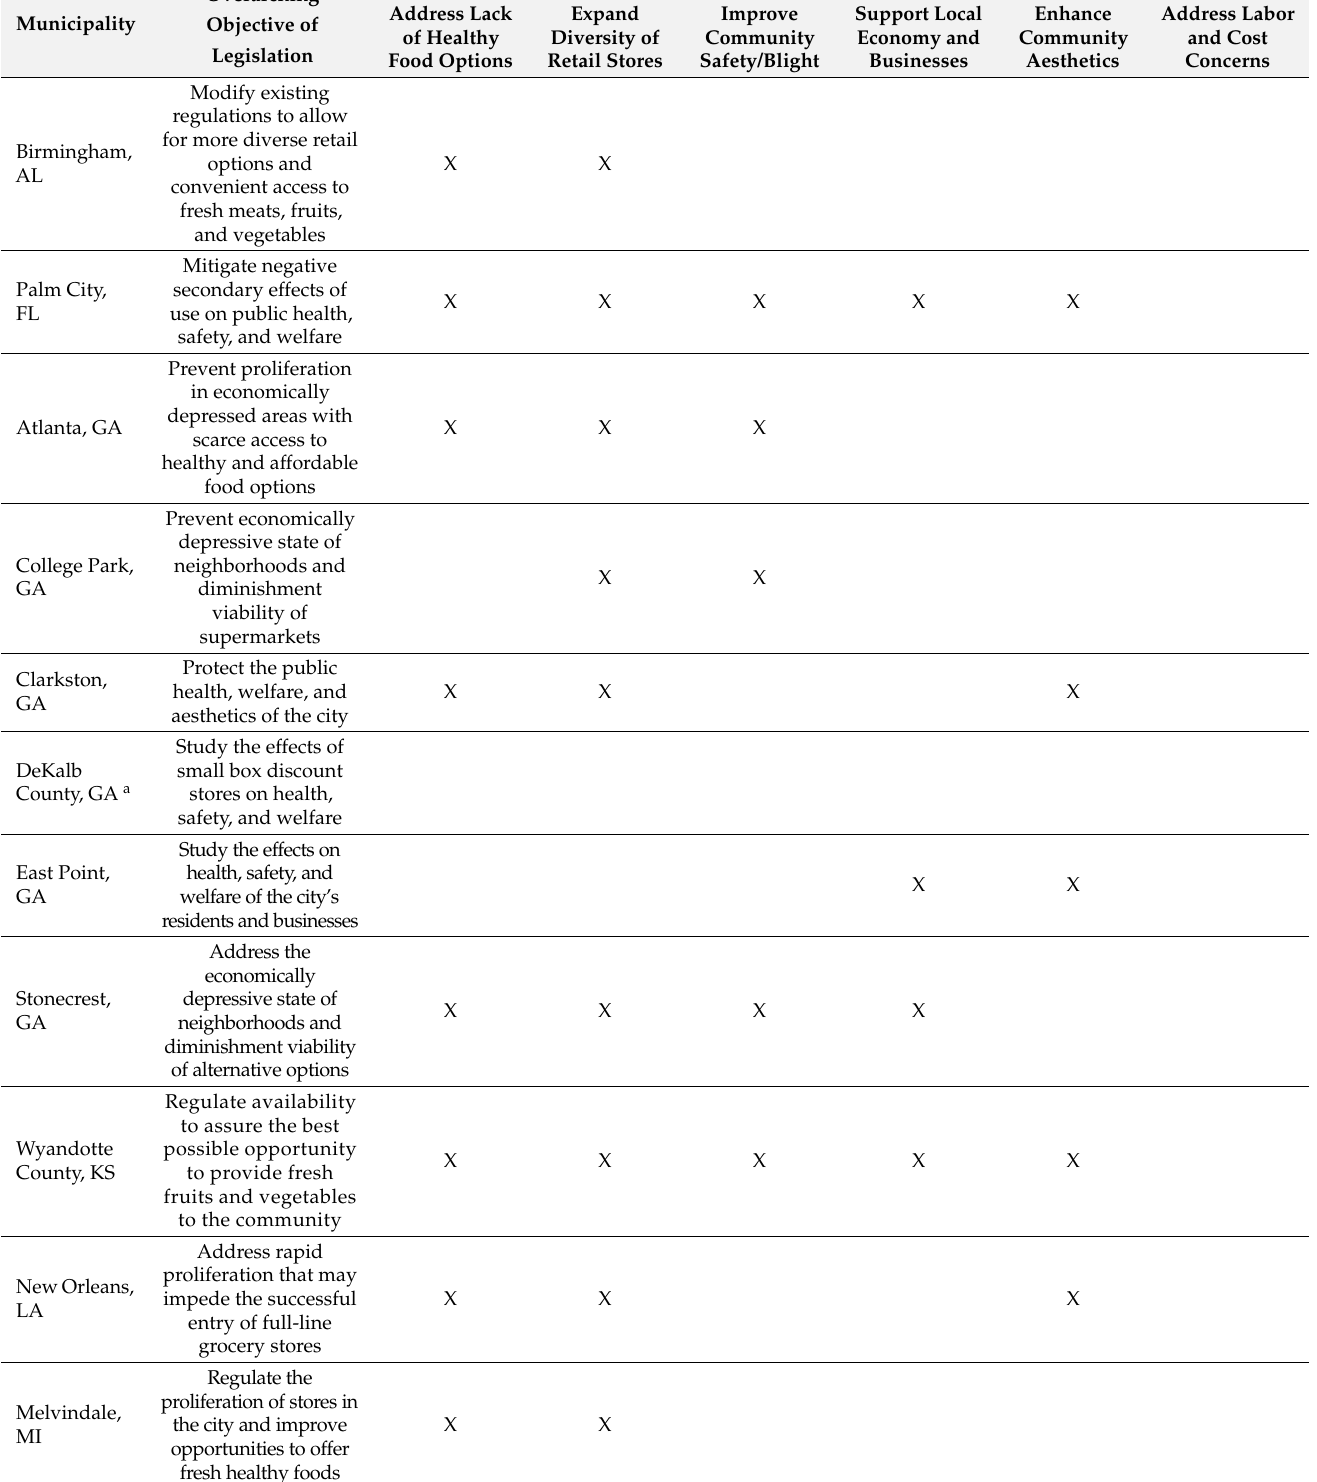
Table 4. Stated purpose of legislation by municipality (N =